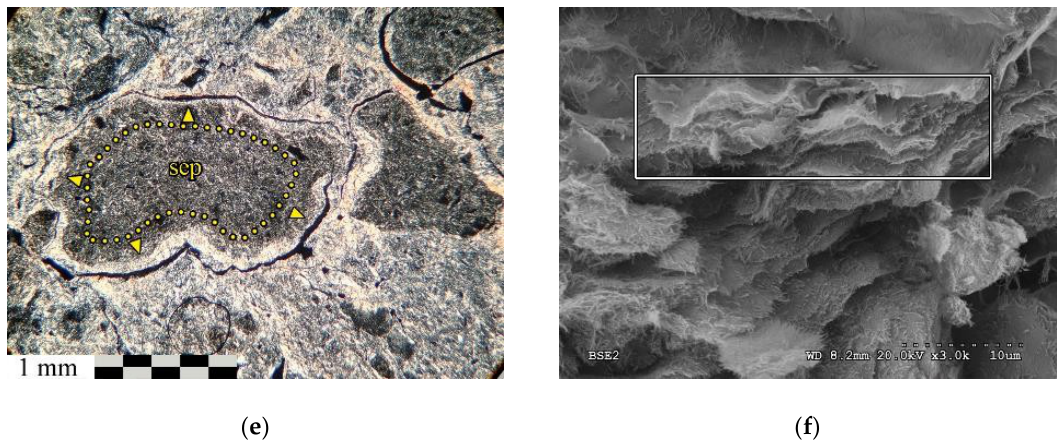
Figure 7. ( a ) Laminated lutite where alternating smectite (sme) and sepiolite (sep) laminae are shown. The transition from one to the other clay mineral in the same lamina is observed in the rectangle (0.3 mm width) (crossed polars and plane polarized light) (LAD-8, lithofacies I.2-A); ( b ) Laminar microfabric showing both thick (yellow points) and thin laminae (LAD-8, lithofacies I.2-A) (SEM, SE); ( c ) Hand sample showing alternating irregular banding where gel-like white sepiolite aggregates infill planar porosities (arrows) (BAT8/9-3, lithofacies I.2-A); ( d ) Hand sample showing grain-supported texture composed of sepiolite intraclasts (1), silty groundmass (2) and sepiolite cements (arrow) (BS2I-6, lithofacies I.2-B); ( e ) Nodular-brecciated sepiolite showing birefringent coatings (arrows) (BA-12, lithofacies. I.2-B) (crossed polars); ( f ) Laminar microfabric composed of interwoven sepiolite fibres (BS2I-7, lithofacies I.2-B) (SEM, BSE).